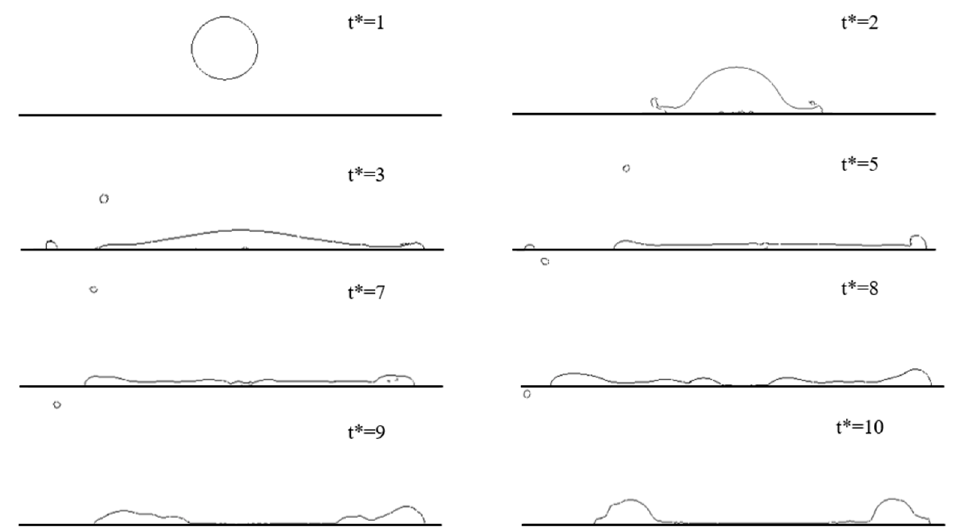
Figure 20. The spreading morphology of droplet on the smooth surface at Weber number of 30.